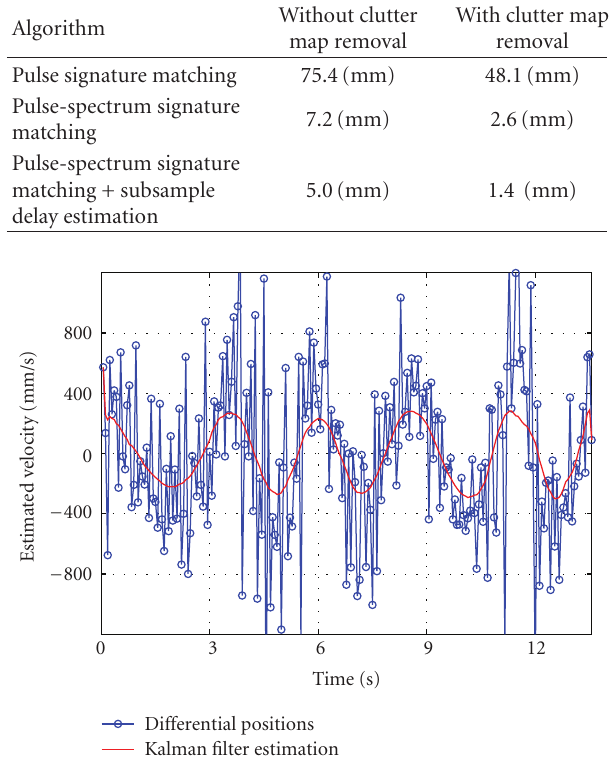
Figure 16: The estimated velocity by the Kalman filter tracking algorithm for the one-dimensional see-through-wall evaluation.